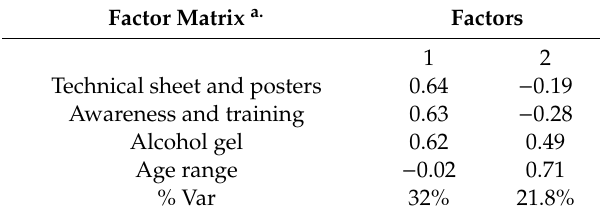
Table 8. Factorial analysis regarding the beliefs of sta ff on key influencing factors. Factor Matrix a.